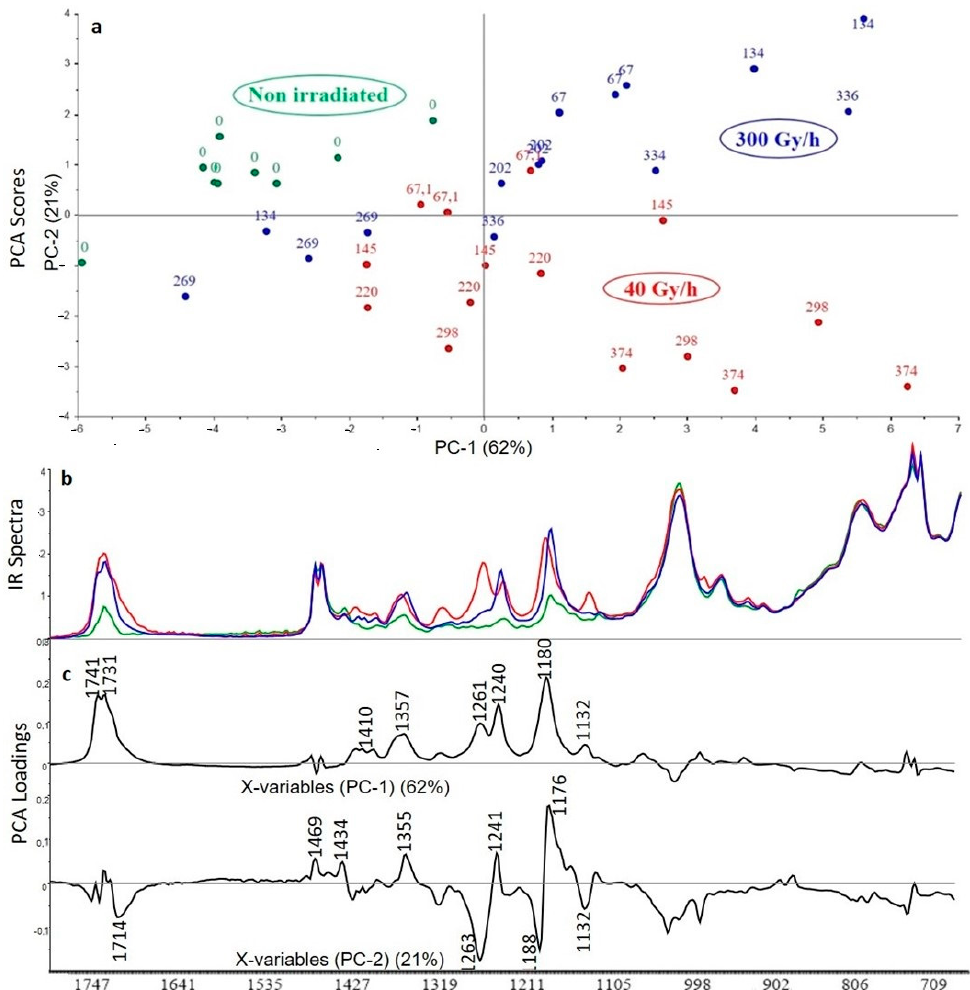
Figure 10. PCA scores ( a ), FTIR spectra for highest dose ( b ) and PCA loadings ( c ) of the first and second principal components (PC1 and PC2) for the analysis of XLPE with ATH, Irganox 1076 and Irganox PS802 (green: unaged samples, red: samples irradiated at 40 Gy/h, blue: samples irradiated at 300 Gy/h).